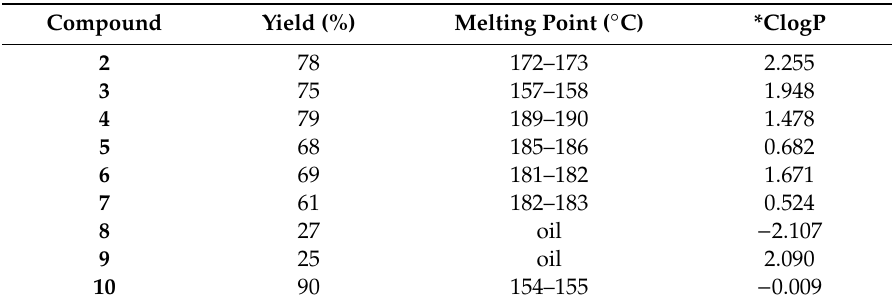
Table 1. Structures, yields, and ClogP of prepared